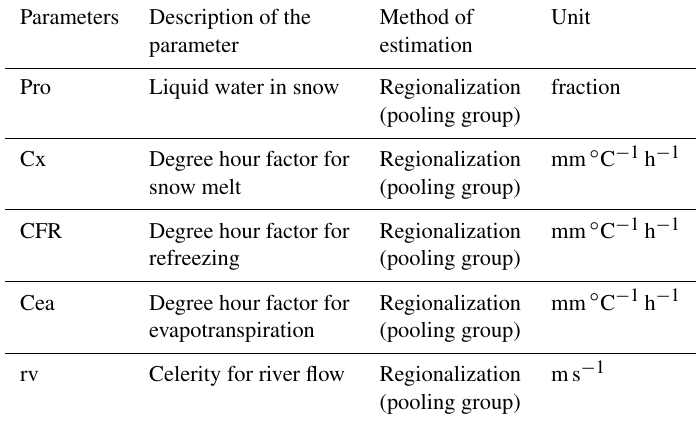
Table A2. List of DDD rainfall–runoff model parameters estimated from pooling groups of physical similarity methods of